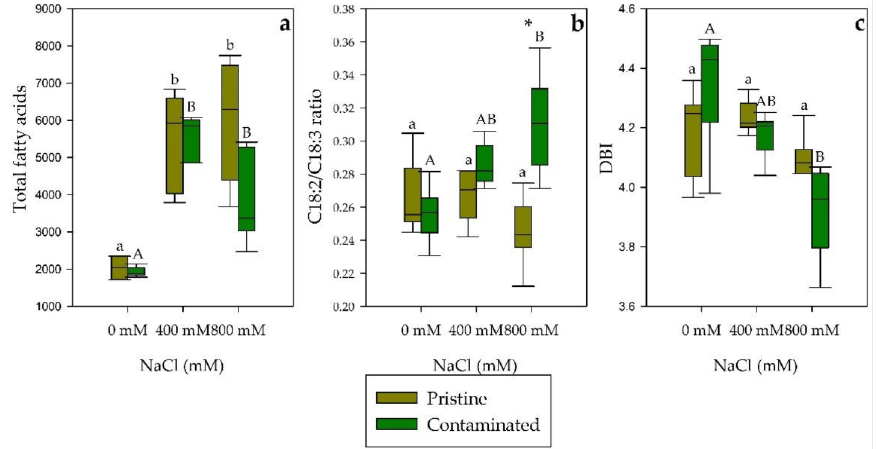
Figure 8. ( a ) Total fatty acid content ( µ g.g − 1 FW), ( b ) linoleic acid to linolenic acid ratio (C18:2/C18:3 ratio), and ( c ) double-bound index (DBI) in S. patens leaves from pristine and heavy metal contam- inated sites (average ± standard error, N = 5), along with the tested NaCl concentrations. Letters indicate significant differences between treatments at p < 0.05; asterisks mark significant differences between populations at p <